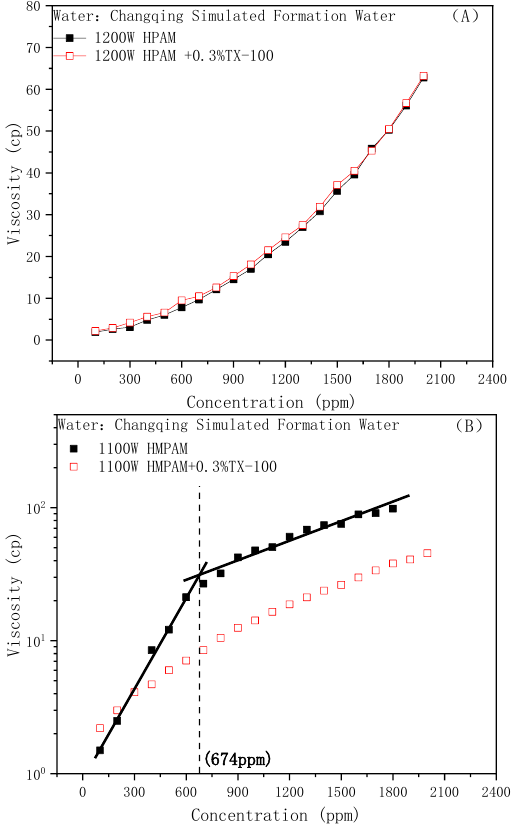
Figure 4. Effect of TX-100 on the polymer viscosity: ( A ) HPAM, ( B ) HMPAM. Figure 3. Effect of TX-100 on the polymer viscosity: ( A ) HPAM, ( B )